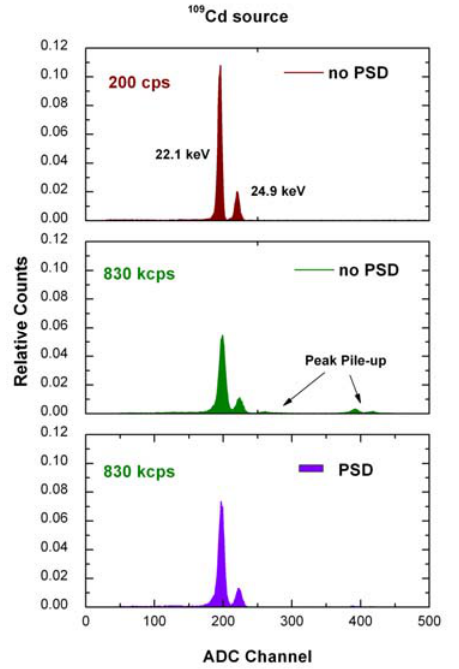
Figure 3. Measured 109 Cd spectra at 200 cps with no correction, at 830 kcps with no correction and at 830 kcps after PSD. The counts were normalized to the total number of detected